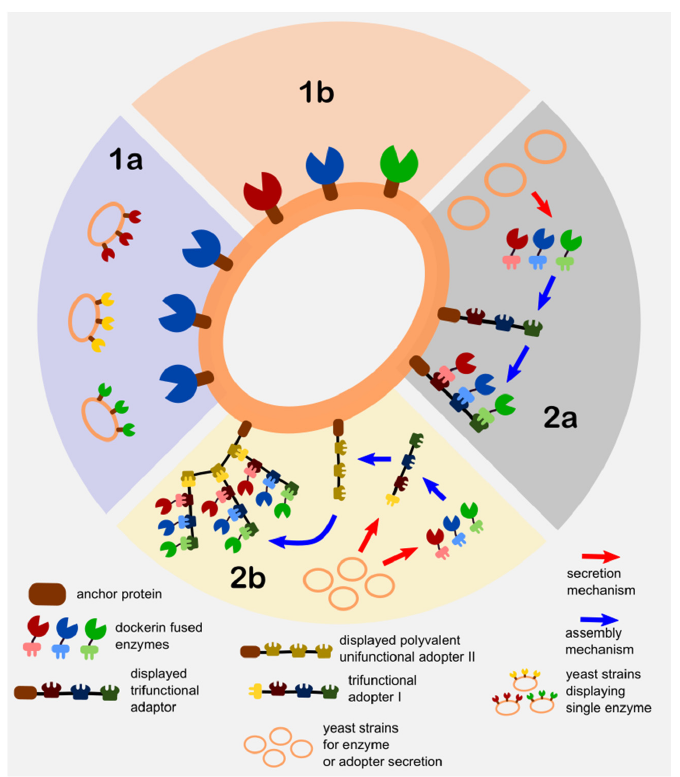
Figure 3. Cellulase and Hemicellulase Surface display strategies for Consolidated BioProcessing. (1a) DYSD ‐ SEDC, (1b) DYSD ‐ CD, (2a) JANNASEY ‐ SMFAA, (2b) JANNASEY ‐